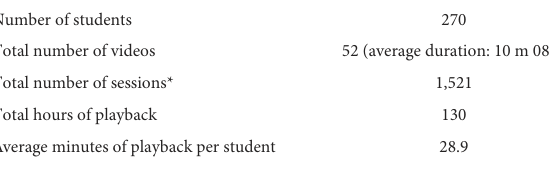
TABLE 3 Overall playback usage during the two